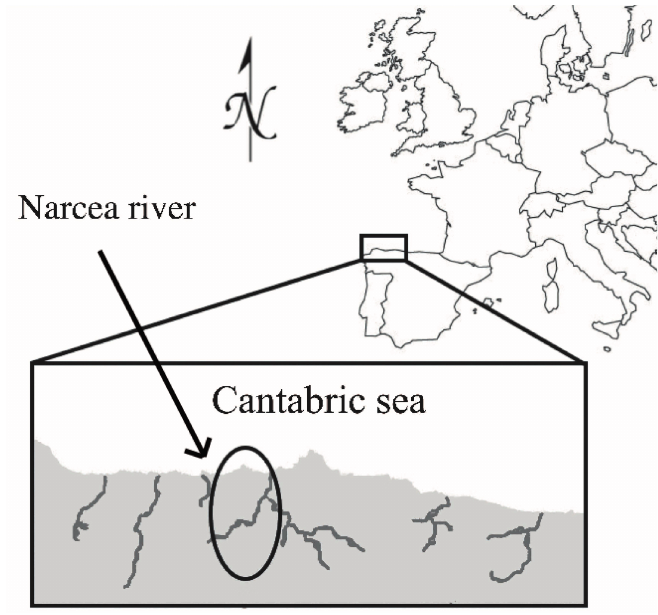
Figure 3. Map of the studied region (north of Spain, Europe) and the river area (High Narcea, in the